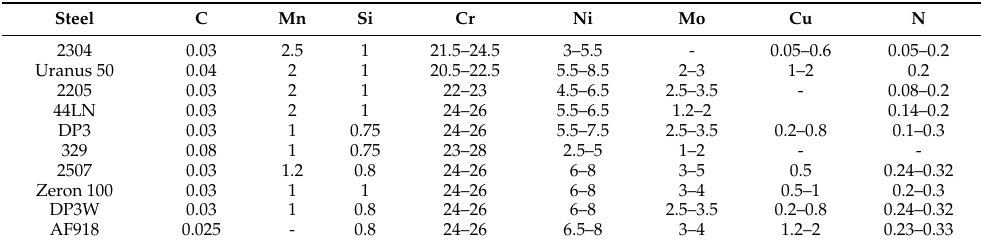
Table 6. Chemical composition of low carbon duplex and superduplex steels, wt%. Data from [19].